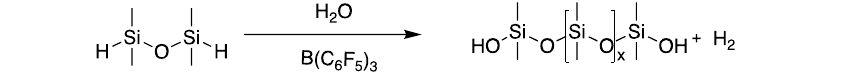
Table 1. High-molecular-weight PDMS (polydimethylsiloxane) preparation using hydrolysis.